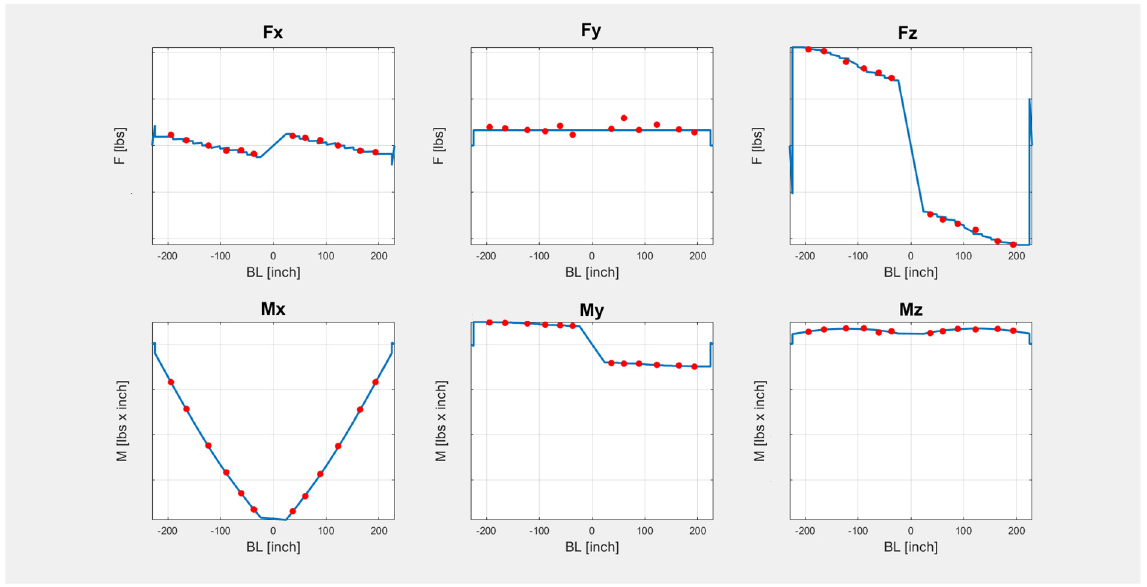
Figure 4. Low speed pull-up maneuver (airspeed = 0.11 V D ; helicopter mode): shear, bending and torsion diagrams (COLD conditions).